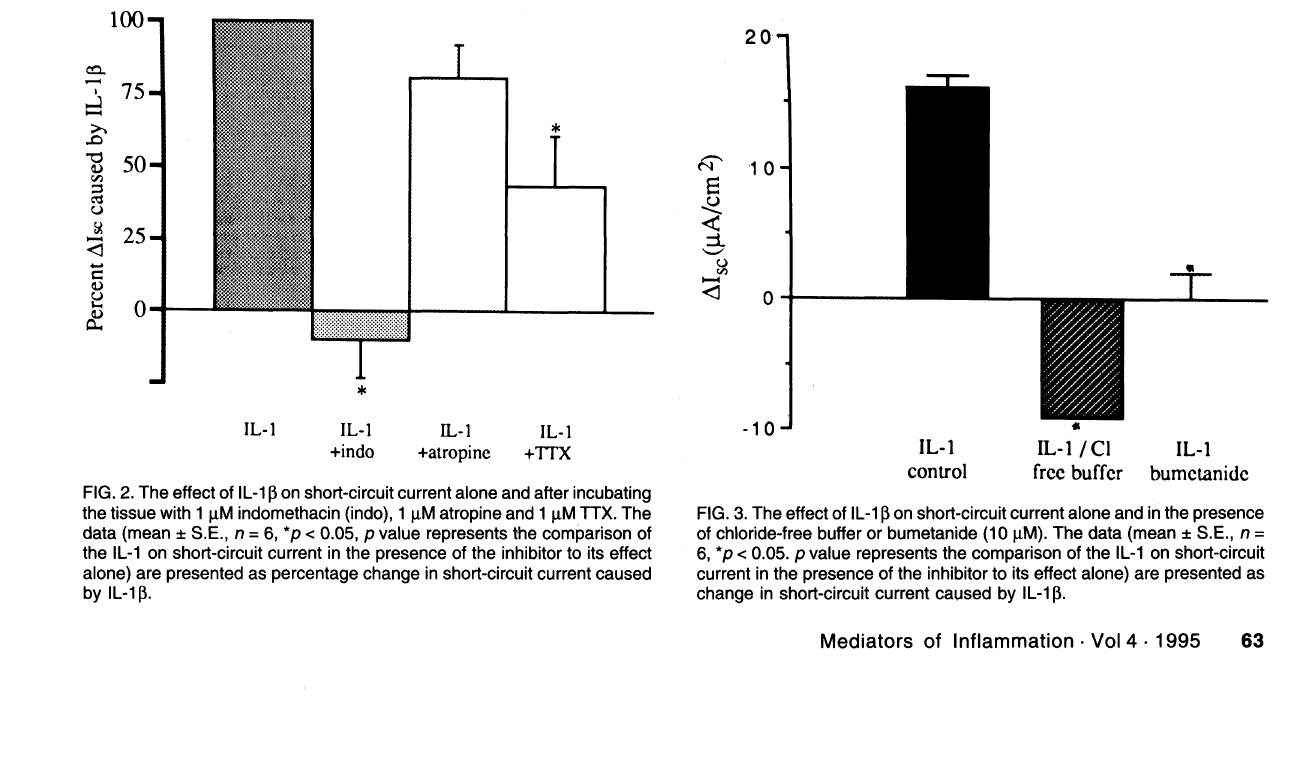
FIG. 2. The effect of IL-113 on short-circuit current alone and after incubating the tissue with l.tM indomethacin (indo), l.tM atropine and tM TTX. The data (mean +/- S.E., n 6, *p < 0.05, p value represents the comparison of the IL-1 on short-circuit current in the presence of the inhibitor to its effect alone) are presented as percentage change in short-circuit current caused by IL-113.